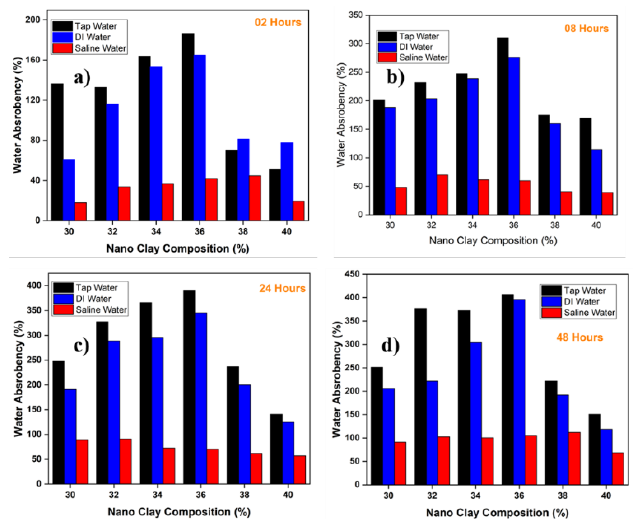
Fig. 5. Water absorption % of SAPCs absorbed in various media for (a) 02 hours; (b) 08 hours; (c) 24 hours; (d) 48